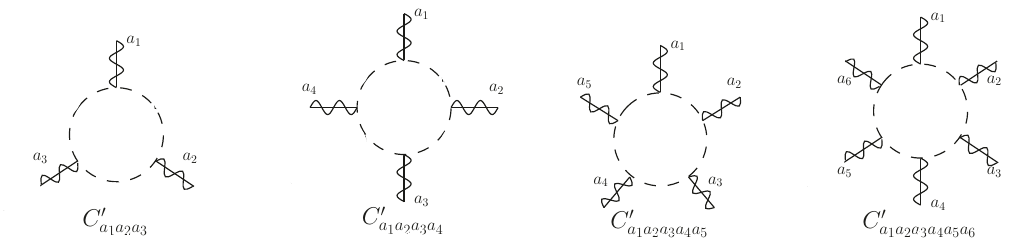
Figure 6 . Building blocks until g 6 order. The overlapped wavy/solid lines stand for generic adjoint (cid:12)elds ((cid:8) or V ).